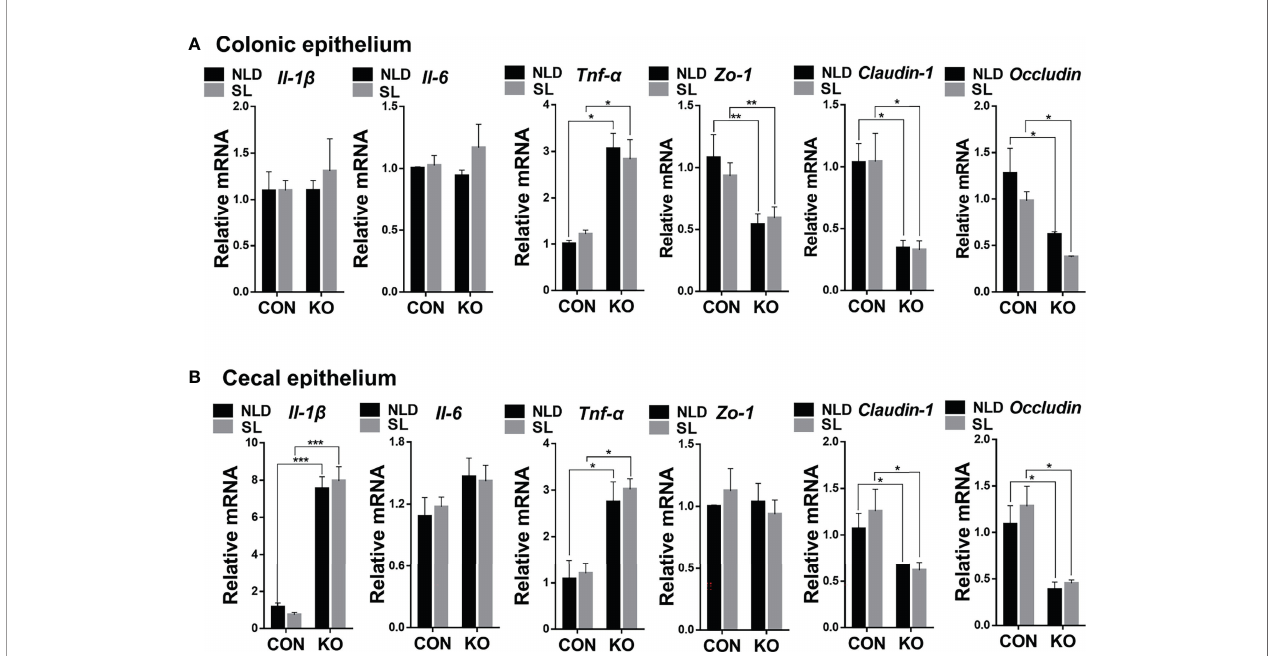
FIGURE 4 | Relative expression of colonic and cecal epithelial in fl ammatory and barrier genes in KO and CON mice under NLD and SL. KO, Per2 gene knockout ( Period2 − / − ) mice; CON, wild-type ( Period2 +/+ ) mice; NLD, normal light – dark cycle treatment of 12 h of light and 12 h of darkness; SL, short-light treatment of 8 h light and 16 h darkness. Representative charts of the expression levels of Il-1 b gene, Il-6 gene, Tnf- a gene, Zo-1 gene, Claudin-1 gene, and Occludin gene of colonic epithelium (A) and cecal epithelium (B) . Expressions of in fl ammatory and barrier genes were determined in Per2 knockout and wild-type mice under NLD and SL by PCR method. Statistical analyses were conducted using two-way ANOVA. * p < 0.05, signi fi cant difference; ** or *** p < 0.01, or p < 0.001, extremely signi fi cant difference. Results are presented as means ± SEM (n = 6 per